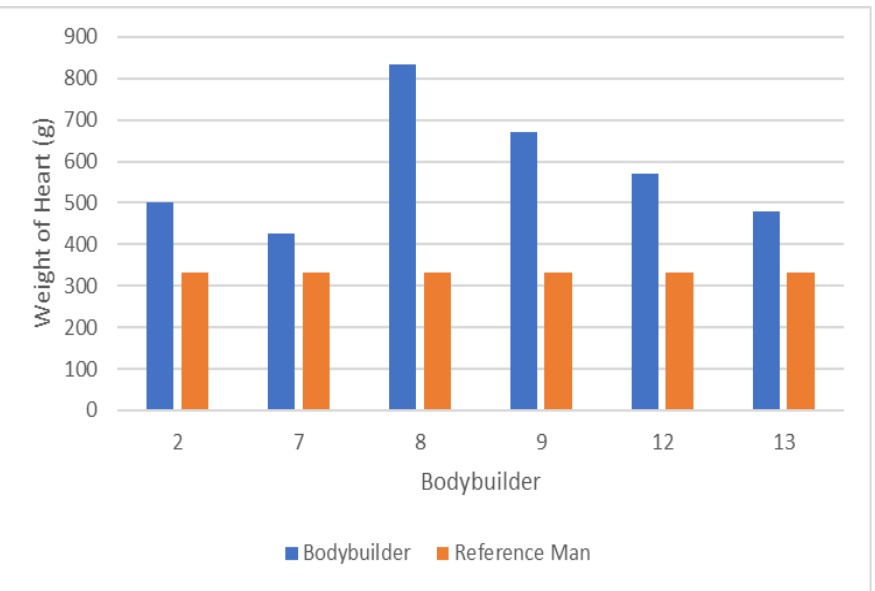
Figure 1. Mean weight of hearts versus reference man. Table 3. Bodybuilder demographics.